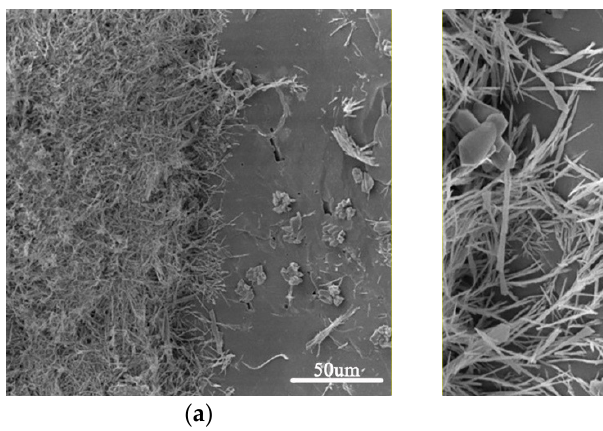
( c ) Figure 3. SEM images of GO-incorporated cement mortar MG4 ( a – c ) at different scales